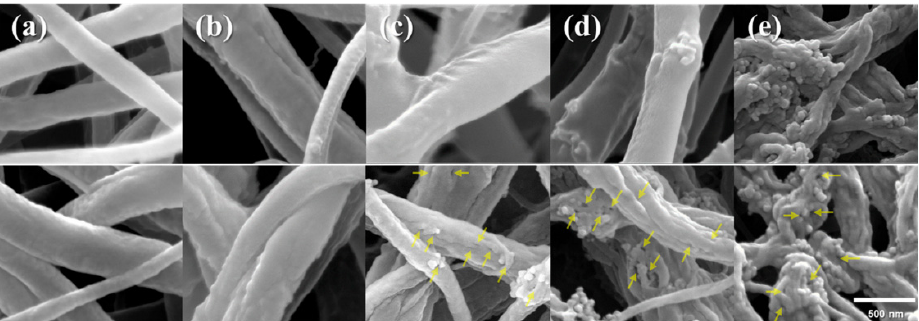
Figure 13. SEM image of the samples with different blending composition: ( a ) PVDF(18%), ( b ) PVDF(18%)-TiO 2 , ( c ) PVDF(12%)/PVP(6%)-TiO 2 , ( d ) PVDF(9%)/PVP(9%)-TiO 2 , and ( e ) PVDF(6%)/PVP(12%)-TiO 2 (Top: before washing; Bottom: after washing). Arrows point to surface pores. (Reprinted from the work of Lee et al. [30]. Copyright 2018, with permission from American Chemical Society).